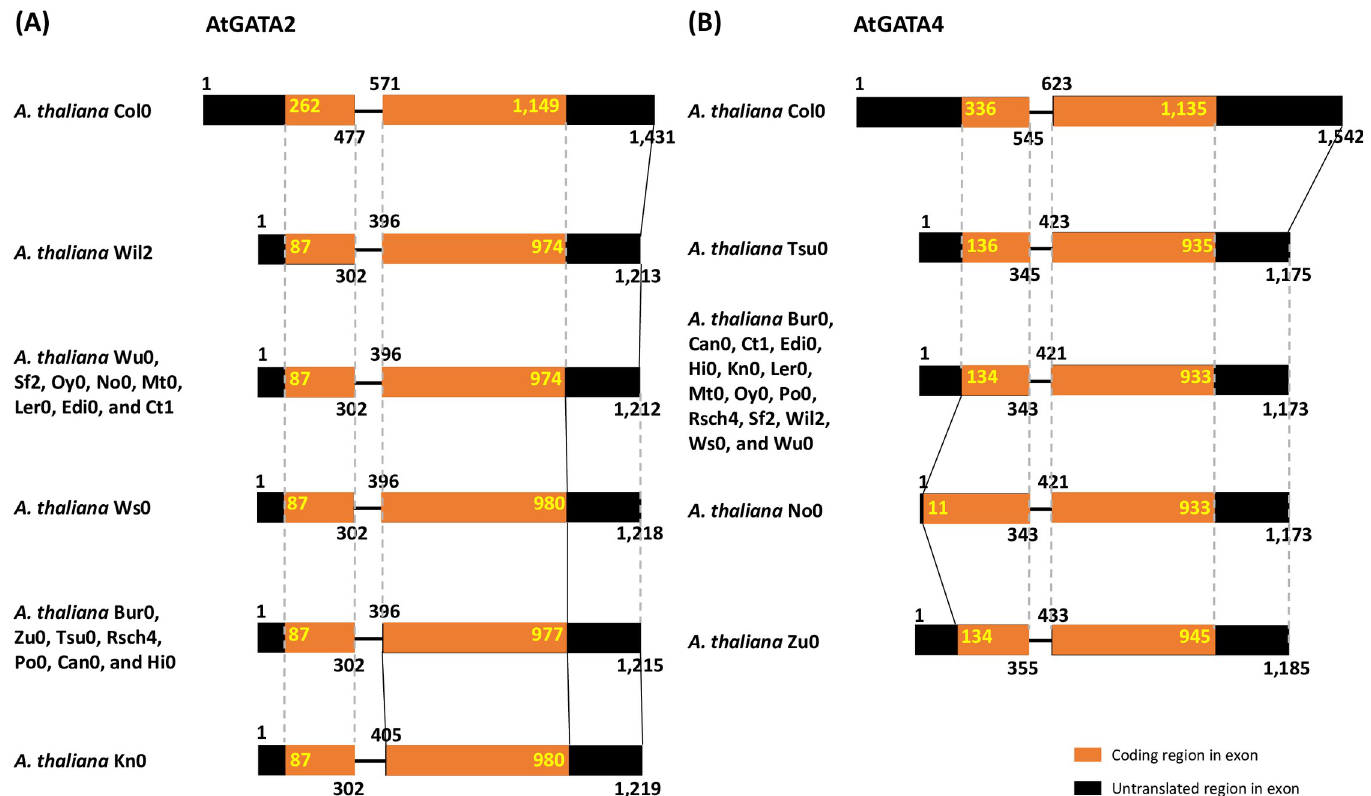
Fig 1. Gene structure of AtGATA2 and AtGATA4 in 19 A . thaliana . (A) shows gene structure of AtGATA2 genes from 19 A . thaliana genomes. (B) displays gene structure of AtGATA4 genes from 19 A . thaliana genomes. Yellow boxes indicate translated regions and black boxes display untranslated regions. Numbers around boxes display relative positions of translated, untranslated, and exons. Names of A . thaliana genomes are printed in the left part of each gene diagram. Dotted and solid lines indicate the conserved and different structure of GATA genes including exon, intron, and untranslated regions, respectively.